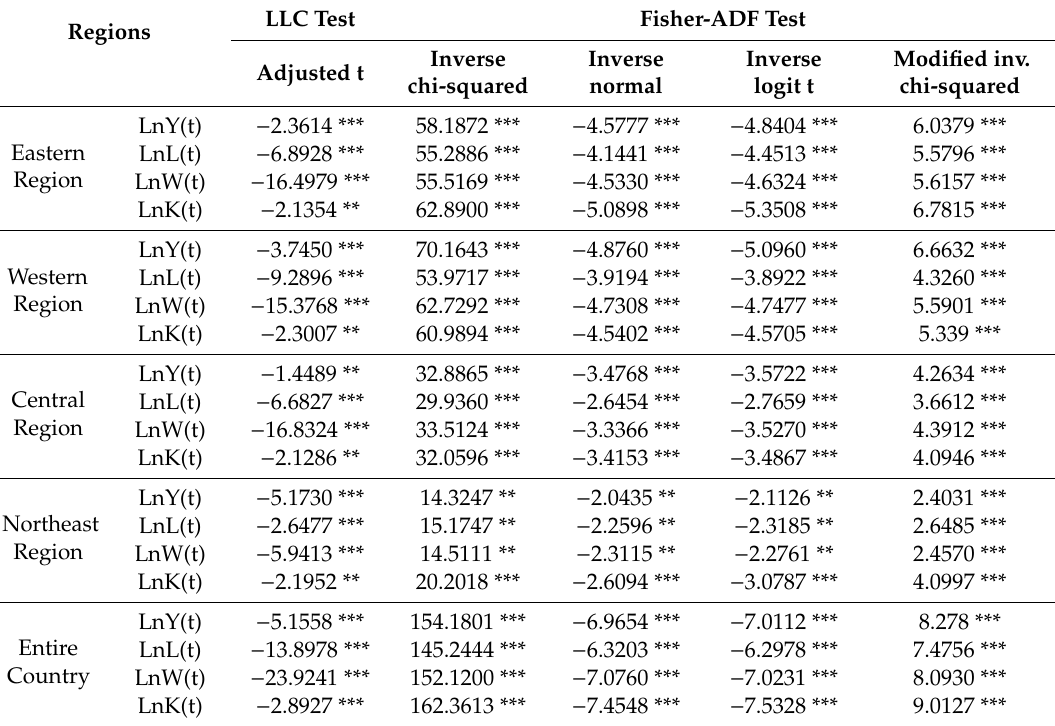
Table A1. Unit root test